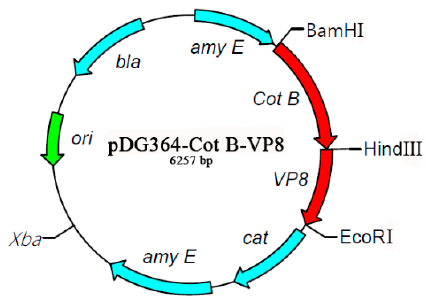
Figure 3. Map of the shuttle vector pDG364-CotB-VP8*. CotB and VP8* genes were integrated in the gene fusion on the pDG364 vector.